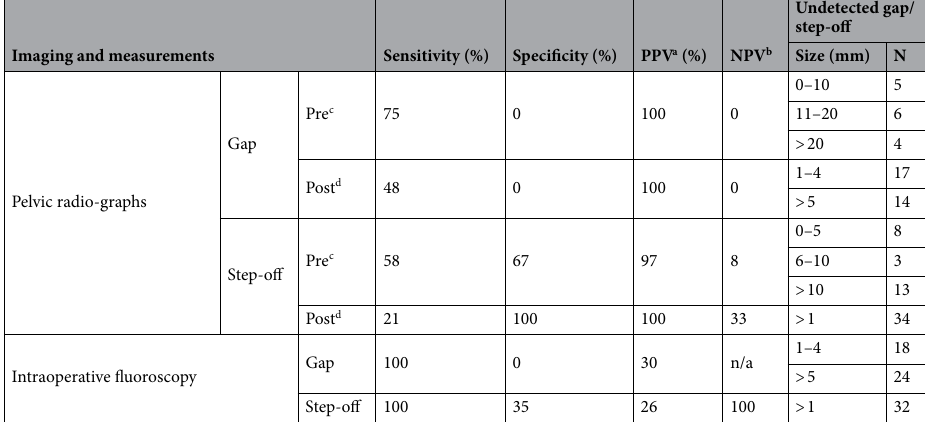
Table 2. The sensitivity, specificity, positive predictive value and negative predictive value of pelvic radiographs and intraoperative fluoroscopy in the detection of gaps and step-offs in acetabular fractures, with computed tomography as the gold standard. Additionally, the size and the number of the undetected gaps and step-offs on pelvic radiographs as well as fluoroscopy are provided. For the postoperative undetected gaps and step-offs the cut-off values presented by Verbeek et al. were used 18 . a Positive predictive value. b Negative predictive value. c Preoperative. d